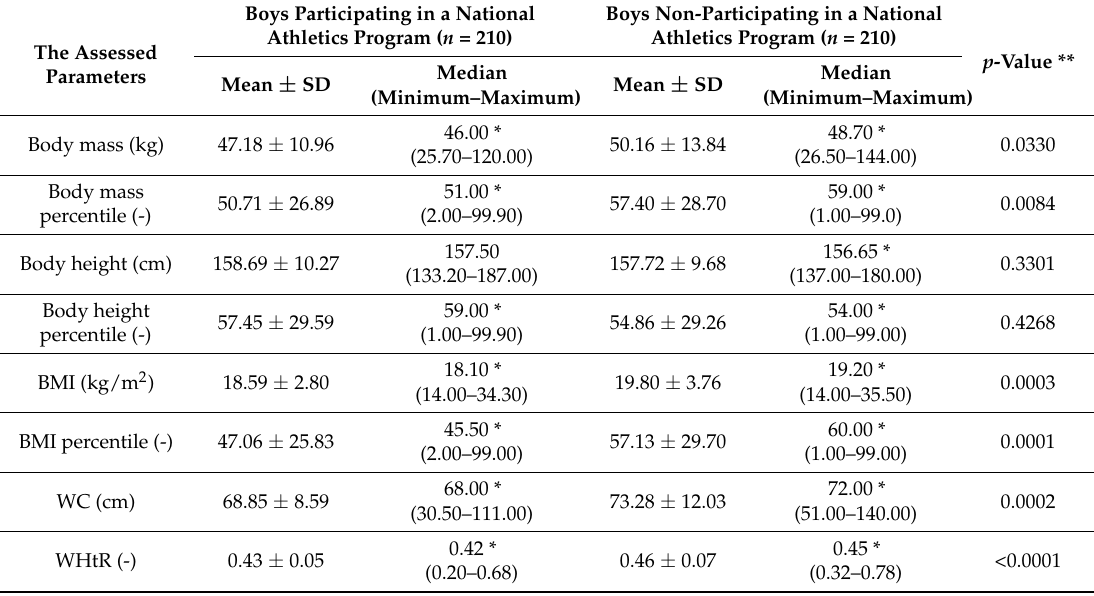
Table 2. The basic anthropometric characteristics of group of boys participating in a national athletics program and pair-matched control group of